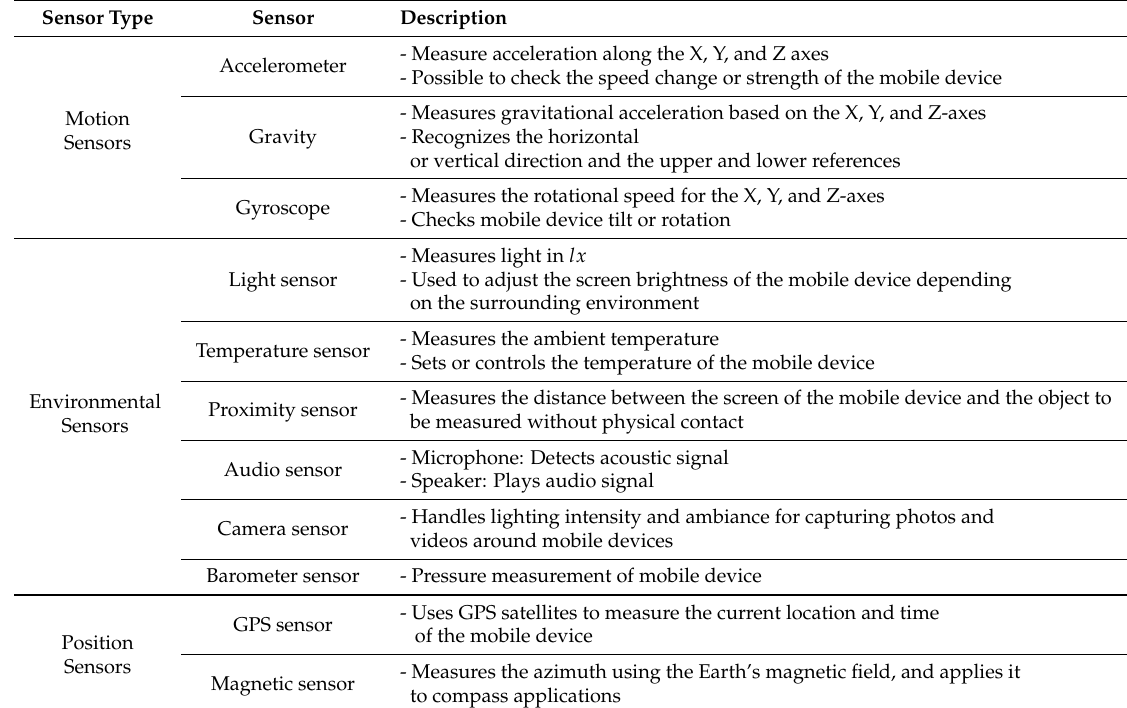
Table 1. Mobile device sensors can be classified into motion sensors, environmental sensors, and position sensors. Information leakage is possible by integrating data from these sensors